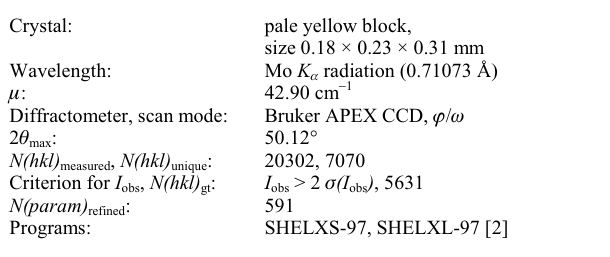
Table 1. Data collection and handling.